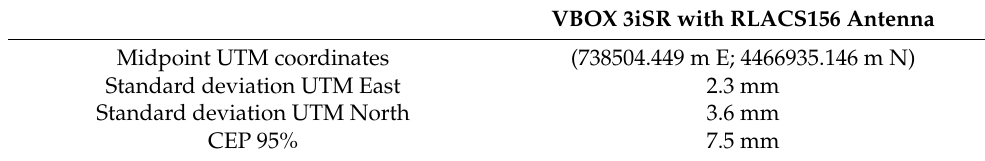
Figure 15. Positioning measures with VBOX 3iSR INS in RTK with antenna model RLACS156; the number next to each point represents the readings with the same north and east coordinates. Table 1. Midpoint, standard deviations, and CEP 95% value related to the positioning measurements on the measuring point with VBOX 3iSR INS in RTK